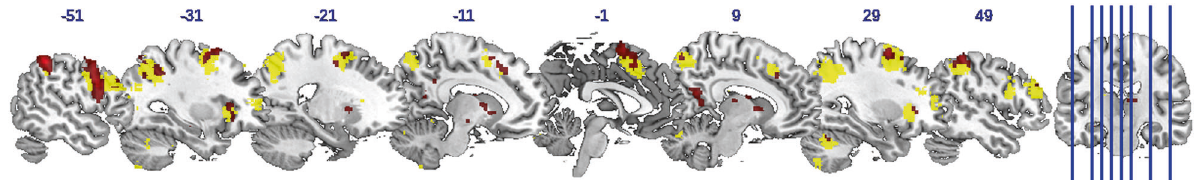
Fig. 2 The F-test results for the main effect of group (in red) thresholded at p < 0.01. It is overlaid over the working memory circuitry derived from the NeuroSynth meta-analysis posterior probability map (in yellow) thresholded at p < differences than HC in the left putamen and inferior frontal gyrus, pars opercularis (LIFG), and the right caudate, frontal opercular cortex, precuneus, and thalamus. The effect sizes were small even for the comparisons with highly signi fi cant FDR-corrected p -values (Supplemental Table S2). Participants ’ age was negatively associated with the 2-back vs.